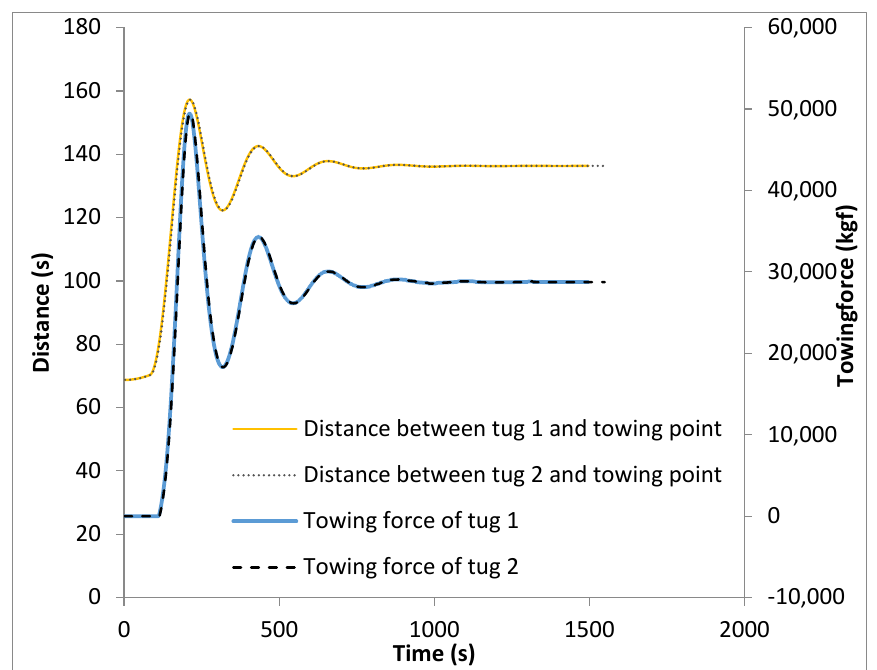
Figure 6. Analysis diagram of longitudinal towing cable force and tug position.